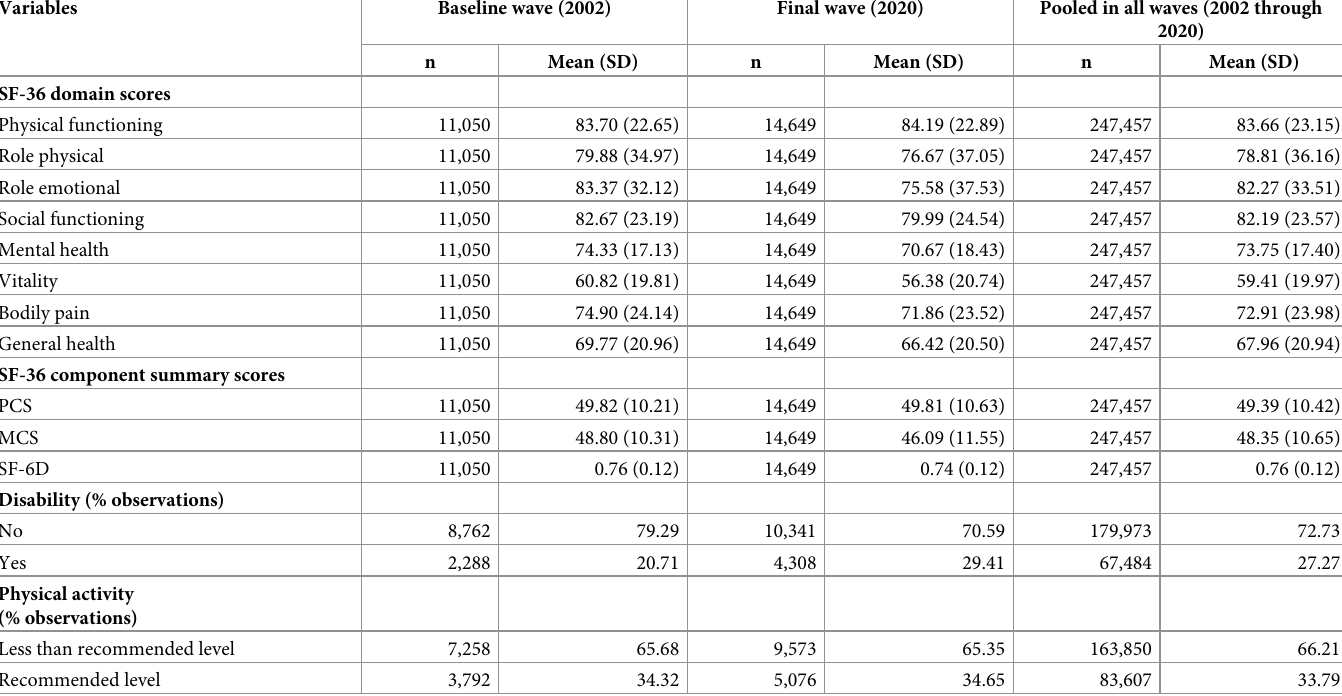
Table 3. Distribution of subjective health scores, disability status and physical activity: Baseline, final and pooled across all waves (persons = 29,973; observations = 247,457).